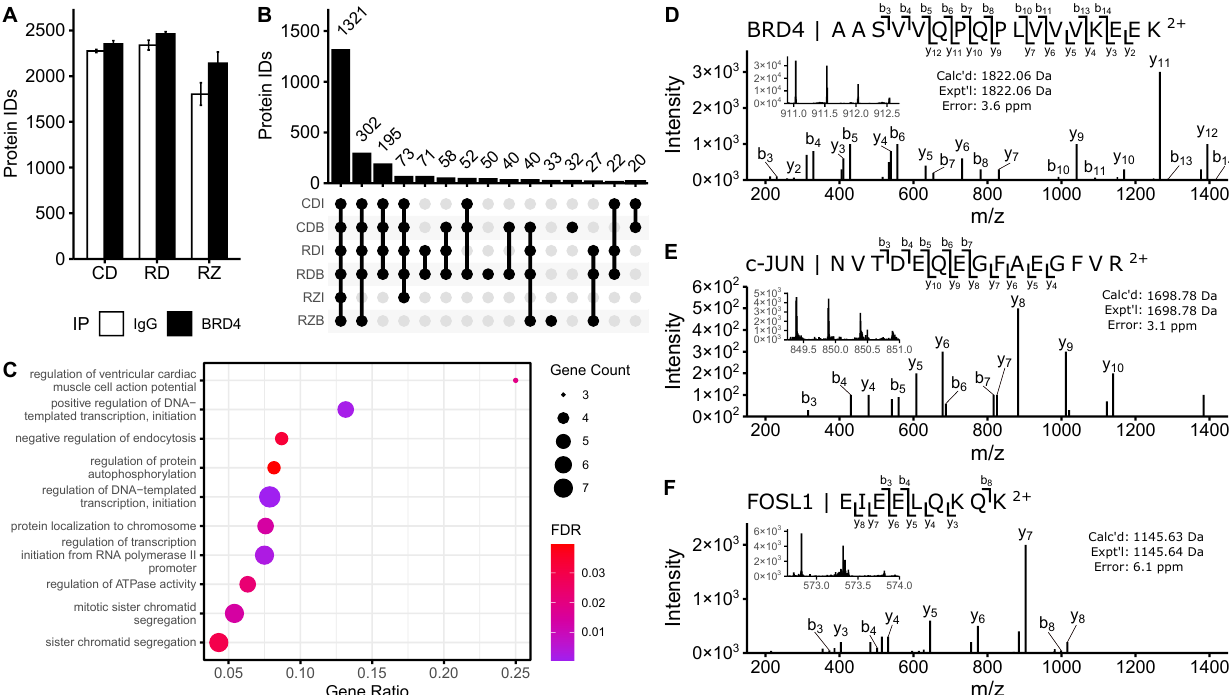
Figure 2. Identification of immunopurified proteins by online LC-PASEF-MS/MS. ( A ) Protein identifications per sample group. Bar plot represents the mean of n = 8 biological and technical replicates. ( B ) UpSet plot of protein identifications shared between sample groups. Protein IDs were filtered to require n ≥ 6 identifications per sample group for representation. ( C ) PANTHER Biological Process GO analysis of proteins identified solely in BRD4 IP groups. Dot size represents the number of identified proteins within a GO group. Gene ratio indicates the fraction of all proteins within the GO group that were identified. Color represents the FDR-adjusted p -value of the GO over-representation test. ( D – F ) Tandem MS identification of characteristic peptides belonging to BRD4 and notable co-purified proteins. All fragment ion charge states are